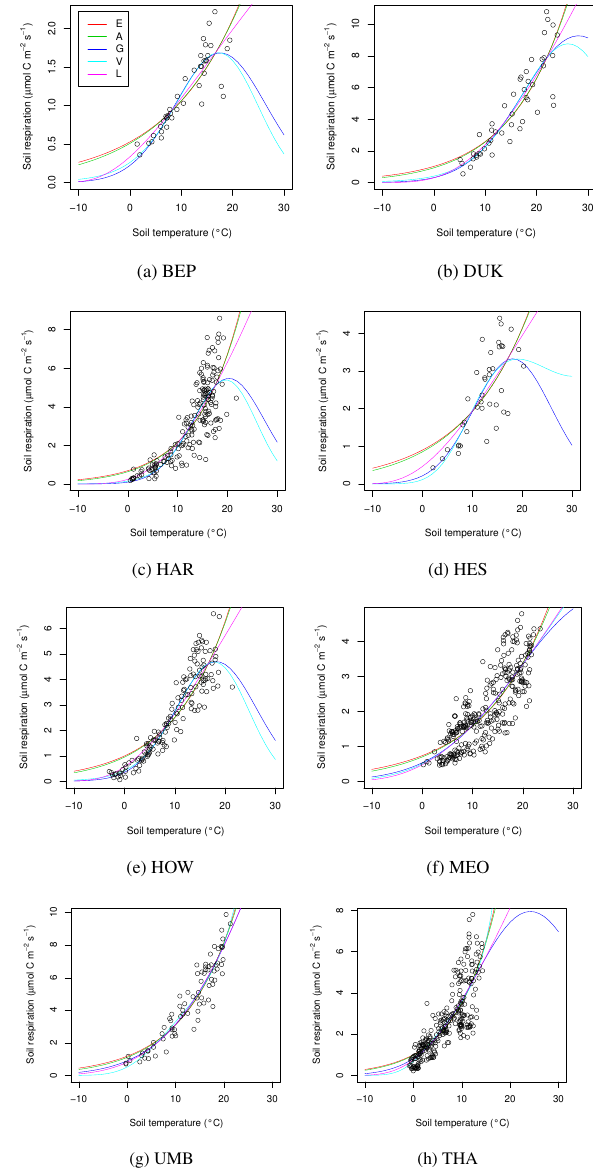
Fig. 1. Best non-linear fit for the soil respiration as a function of soil Fig. 1: Best non-linear fit for the soil respiration as a function of soil temperature for all sites are shown (E: Exponential, A: